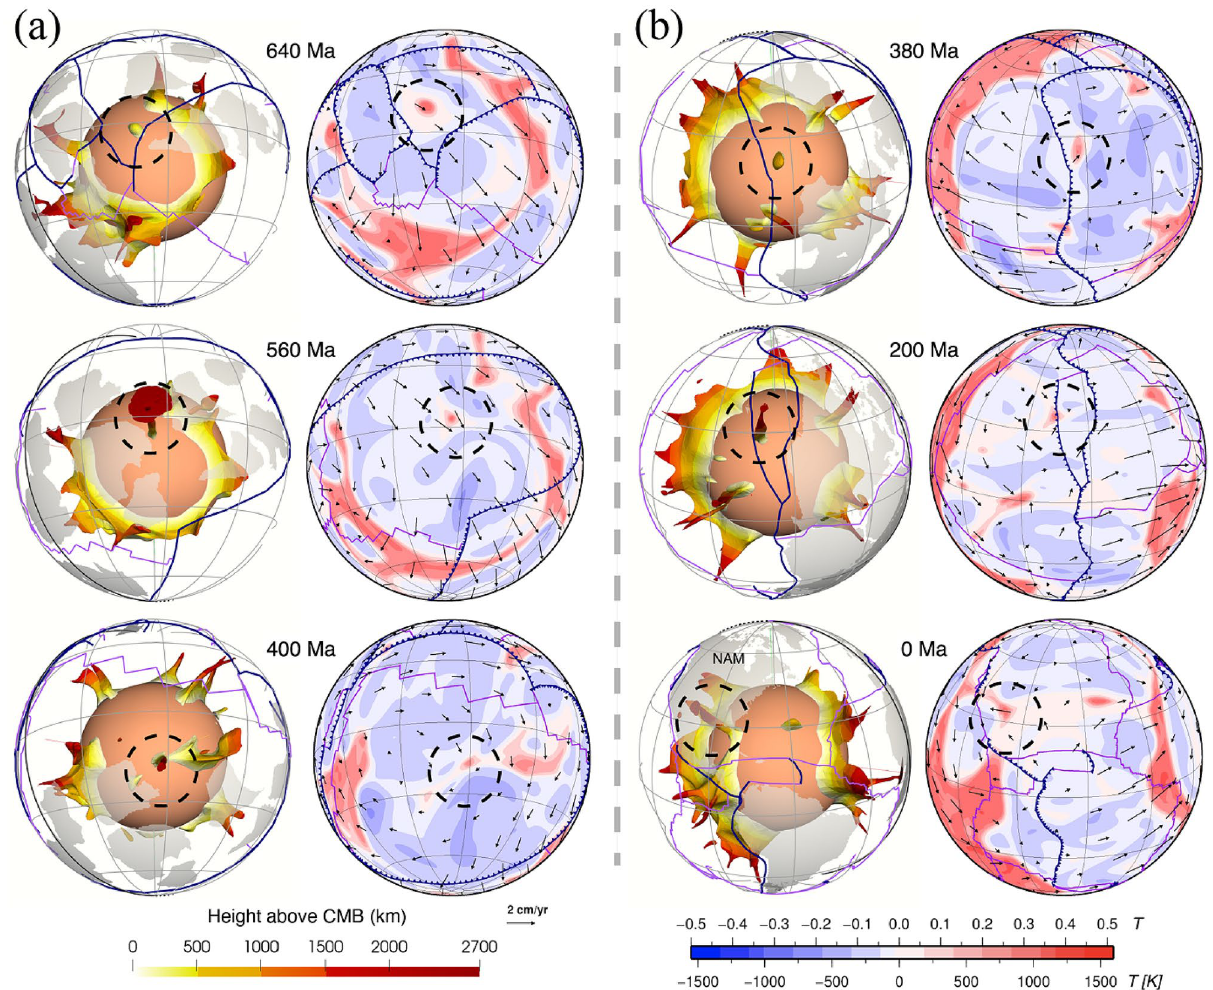
Figure 7. Formation of two distinct lone plumes (one in (a) and one in (b) , both marked by black dashed circles) due to (a) the sinking of a small network of slabs or (b) a small basal thermochemical structure is carved from a major thermochemical structure. In both (a) and (b) , the left panels show the thermochemical structures, the right panels show temperature anomaly at 2595 km depth. The lone plume in (a) merges with a small thermochemical structure at 400 Ma, and the lone plume in (b) connects to the northeastern Pacific thermochemical structure through two thin thermochemical ridges. The solid and dashed black meridians are longitudes 0º and 180º, respectively. NAM North America. Symbols are as in Fig. 2. This figure was created using the Generic Mapping Tools version 4.5.5 (https:// www. gener ic- mappi ng- tools. org/) 85 and ParaView version 5.8.1 (https:// www. parav iew. org/) 86 margins 14,20 . Studies of the splitting of Earth’s free oscillations 65 suggest high-density anomalies of less than 1.7% and 1% at 2850 km and 2300 km, respectively, in LLSVP regions. Tidal tomography suggests that the positive density contrast might be as little as 0.5% (ref. 66 ), and global tomography including Stoneley modes suggest that LLSVPs are purely thermal structures 67 . The buoyancy ratio we use here for thermochemical structures (B = 0.25) corresponds to an excess density equal to 1%, and results in predicted thermochemical structure with heights (~ 600–800 km) comparable to seismic observations. Previous laboratory or modelling studies have shown that the long-term (e.g., the age of the Earth) survival of the dense basal thermochemical structures require an excess density larger than ~ 2% (buoyancy ratio equal to 0.5, ref 68 ), ~ 2.3% (refs. 59,69 ) or 3% (ref. 70 ) compared to the surrounding mantle. The persistence of the basal layer also depends on other parameters including the Rayleigh number and viscosity of the denser layer 59,60 . Our model shows some entrainment of dense material 59 (Fig. 3 and Supplementary Fig. S1), implying that the denser layer would not persist over Earth’s entire history or could not be assumed as primordial. The excess density deduced from our models is not directly comparable to that deduced from seismic tomography. Indeed, the conversion of mantle temperature predicted by mantle flow models to seismic velocities and the application of a tomographic filter 3,71 suggest that compositionally distinct basal thermochemical structures are not required to obtain sharp Vs gradients, and that the anticor- relation of bulk and shear velocities could be associated with the post-perovskite phase transition. However, the LLSVPs are generally proposed to reach a height of more than 700 km above the CMB 13,14,18 , which cannot be